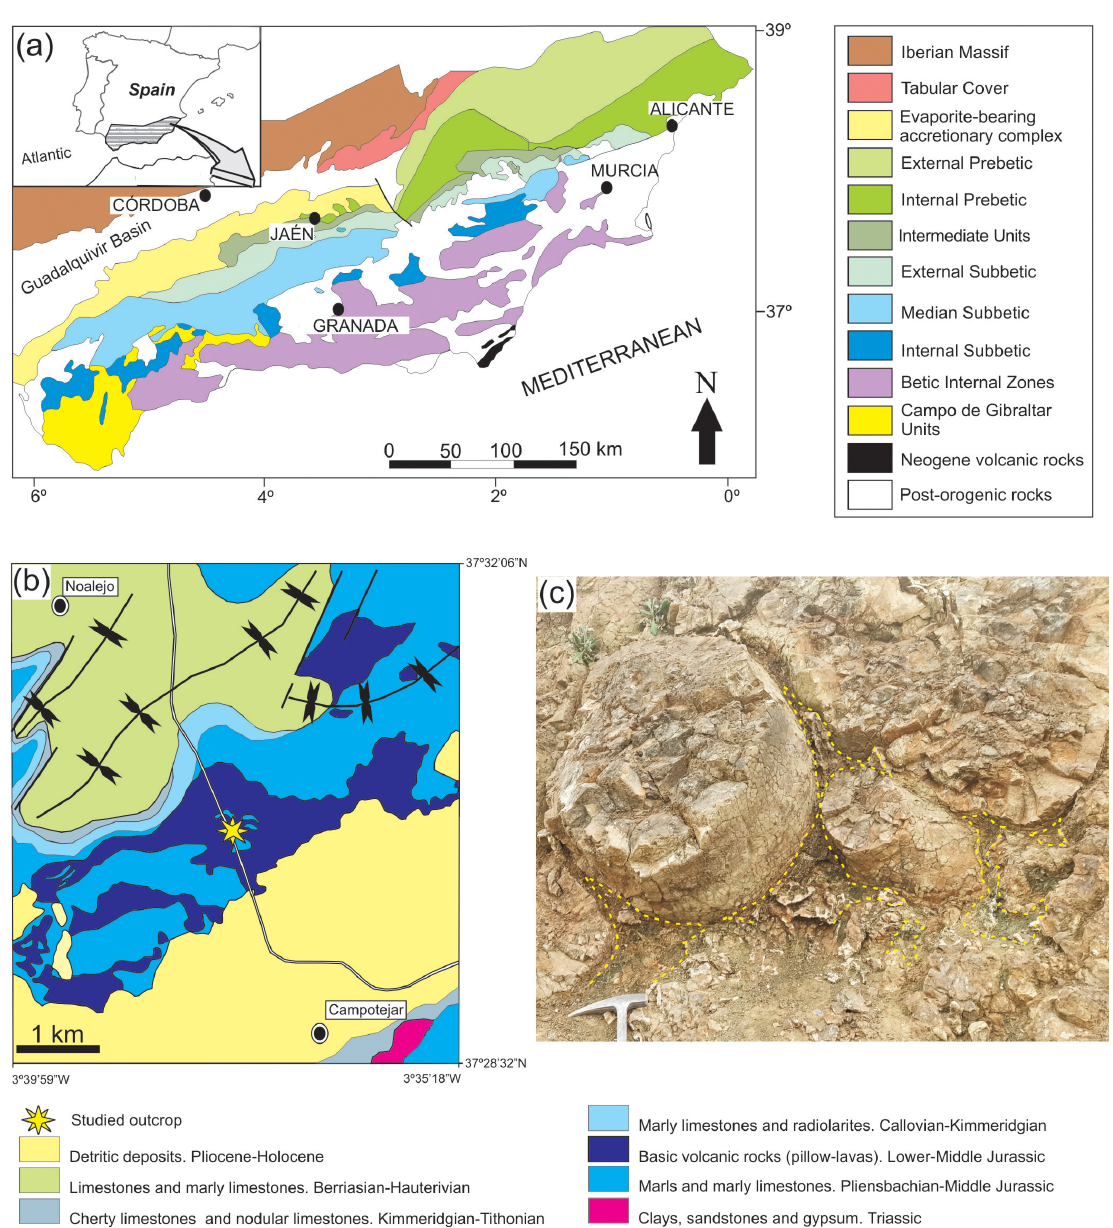
Figure 1. Location of the outcrop where samples were collected: (a) regional location, (b) detailed geological setting of the Campotéjar pillow-lava outcrop and (c) detail of the outcrop of pillow lavas with the studied voids among them (yellow lines).